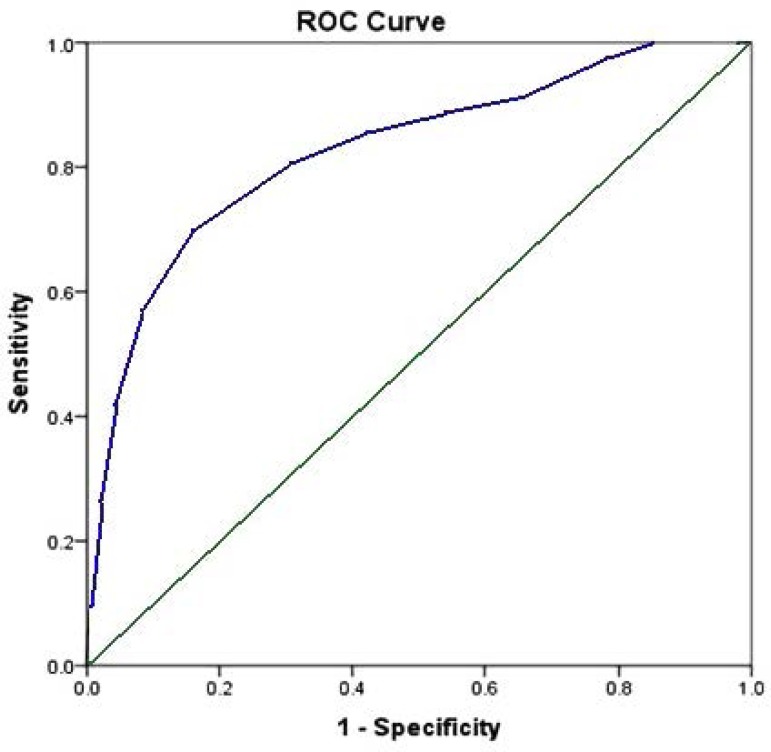
Receiver operating characteristic (ROC) curve for initial predictive
model.